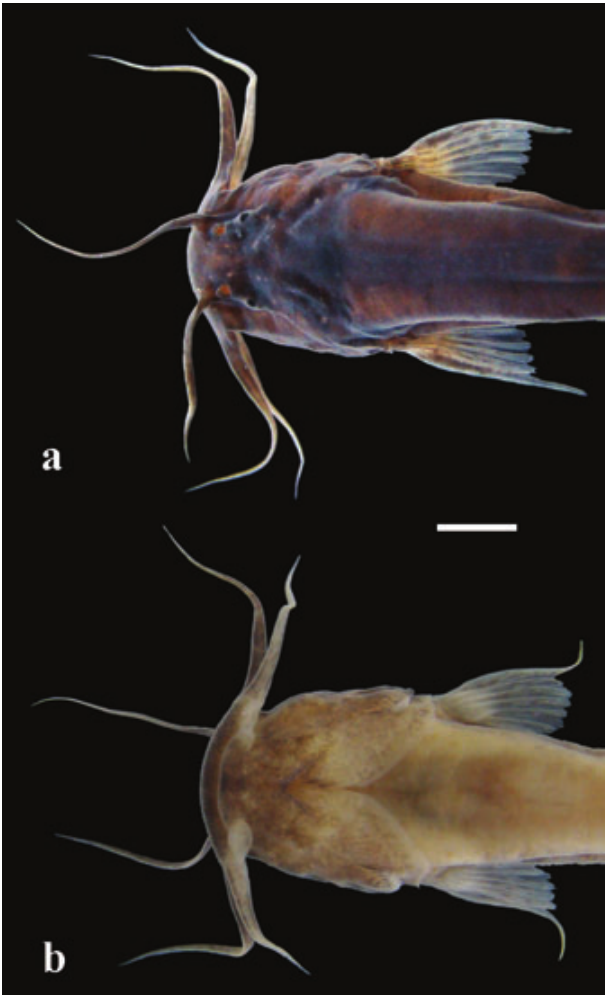
Fig. 2. Ituglanis ina , MPEG 19613, holotype; ( a ) dorsal and ( b ) ventral view of the head. Scale bar = 5